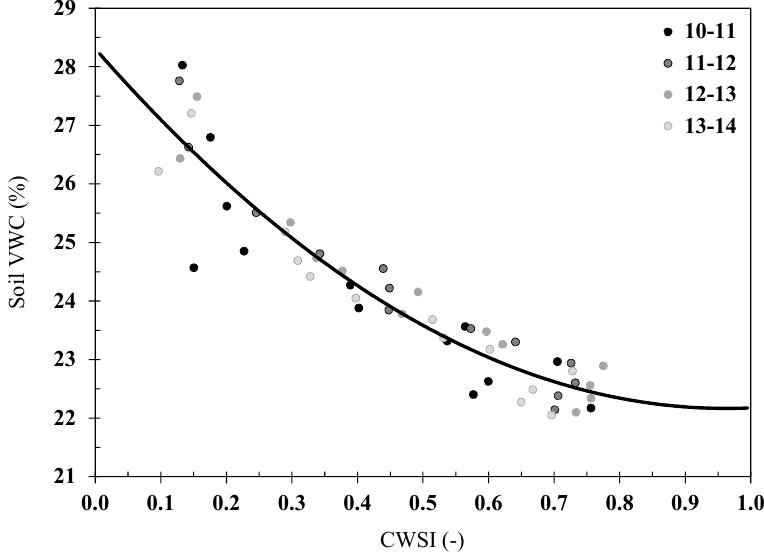
Figure 4. Scatterplot of CWSI vs. volumetric water content (VWC) for the topsoil at plot L-2.1 during a 13-day period (16 August–28 August